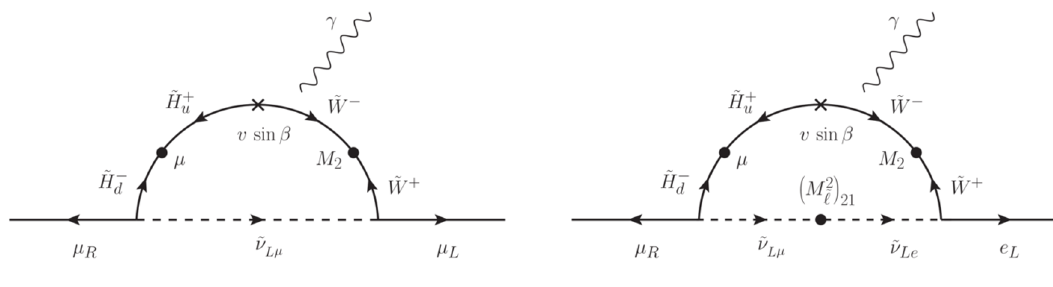
Figure 2 . Diagrammatic representation of the leading contribution to a susy (right) in our